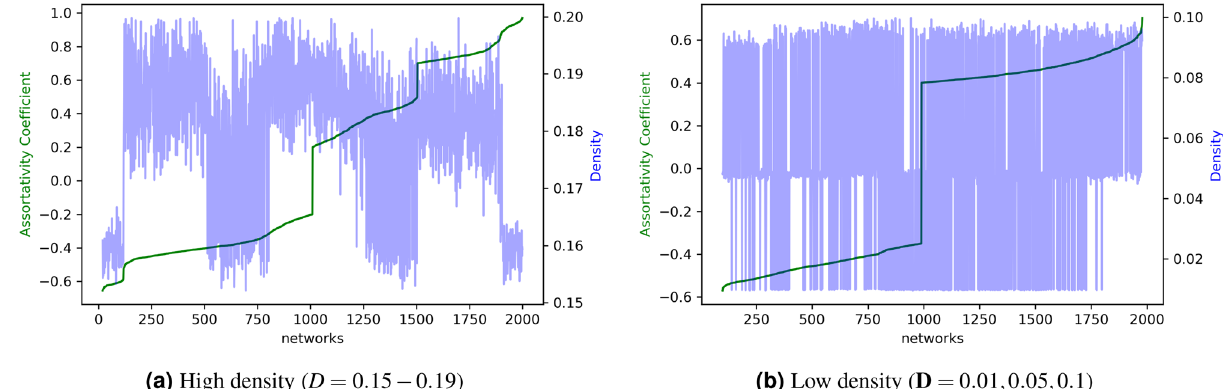
Figure 3. Assortativity coefficient value ( r ) and the corresponding density ( D ) for all the synthetic networks ranked in the increasing order of assortativity. ( a ) shows the correlation between r , D using high density ( D = 0.15, 0.19 ). ( b ) shows the correlation between r , D using low density ( D = 0.01, 0.05, 0.1 ). (In each figure, the first 1000 networks correspond to disassortative (or mode m = 1 ), while latter 1000 networks are for assortative (or m = 0